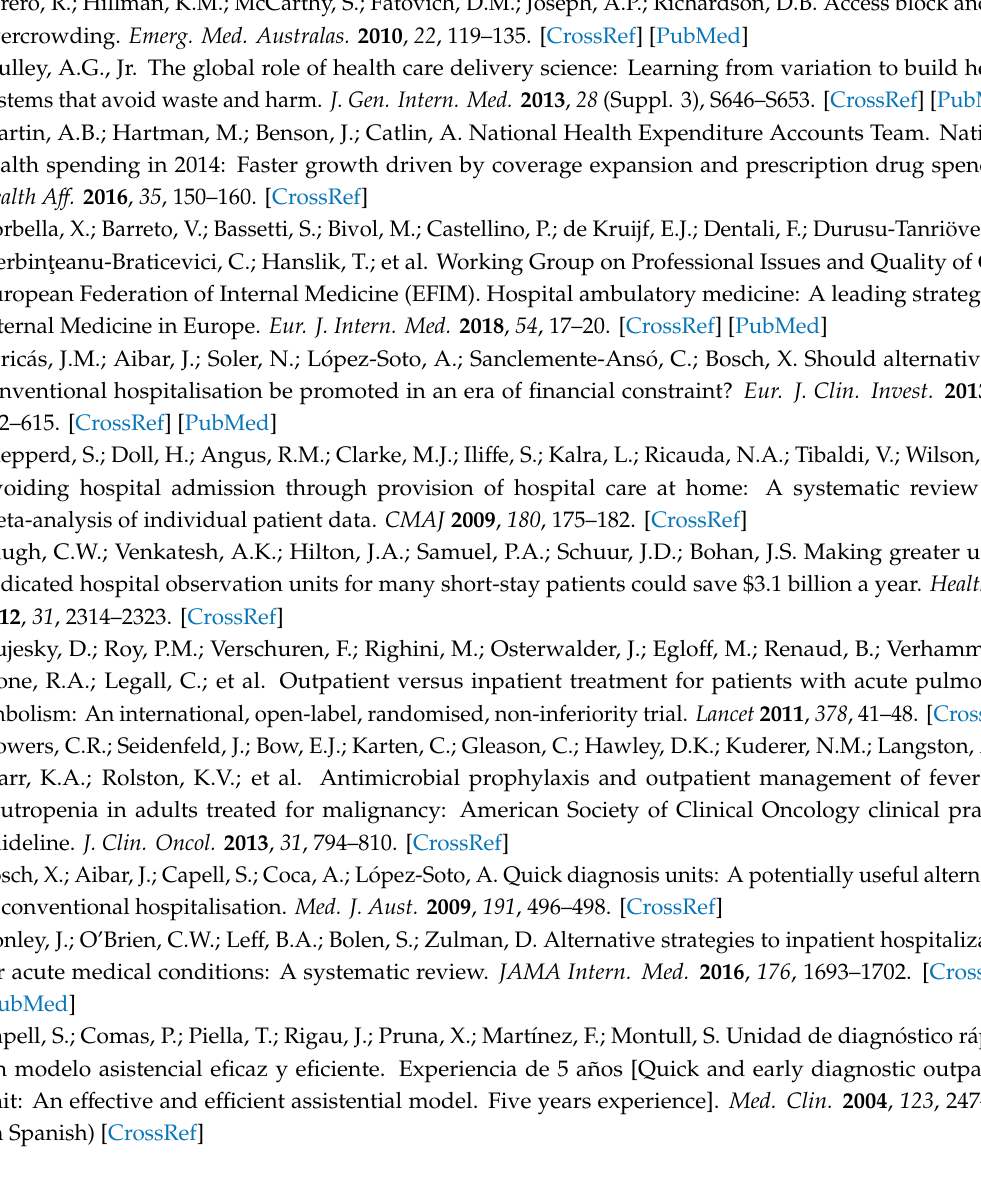
Figure S1: Appropriateness Evaluation Protocol-based chart form used to determine the appropriateness of admissions including justification of appropriateness and reason for